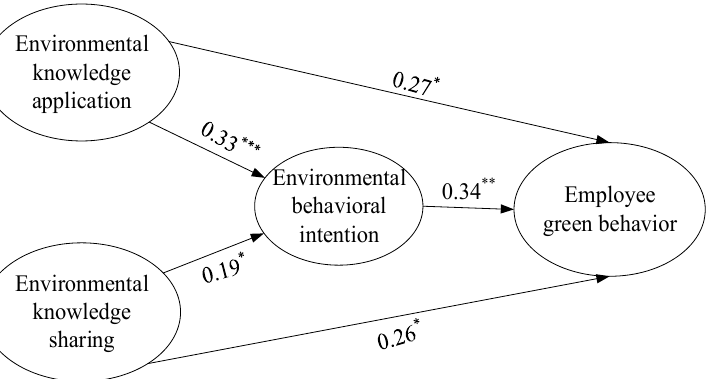
Figure 2. Structural equation model results of primary and mediating effects. Source: edited